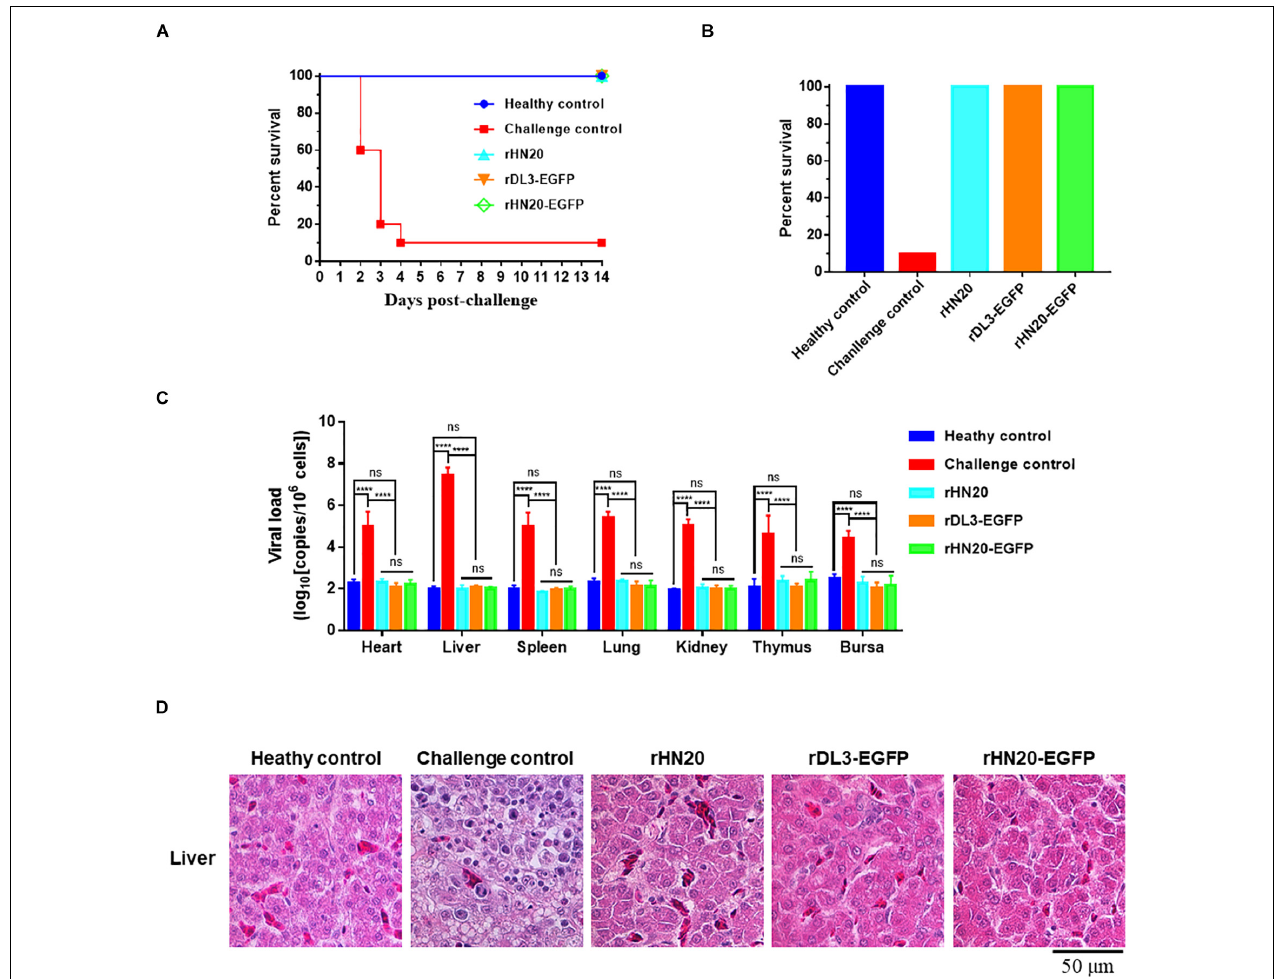
FIGURE 5 | Protection against FAdV-4 lethal challenge by live recombinant fluorescent viruses. Two-week-old SPF chickens ( n = 10) were injected with live rHN20, rDL3-EGFP, or rWT-EGFP and challenged with a lethal dose of FAdV-4 at 14 days post-injection. The healthy control was not treated. The challenge control was challenged but not immunized. (A) Survival curves of challenged chickens. (B) Survival rates of challenged chickens. (C) Viral loads in different tissues of challenged chickens. Heart, liver, spleen, lung, kidney, thymus, and bursa from dead or euthanized chickens were collected, and viral loads were determined using real-time PCR ( n = 3). ****Significance at P < 0.0001; ns, no significance. (D) Histological examination of liver from challenged chickens. Scale bar, 50 µ